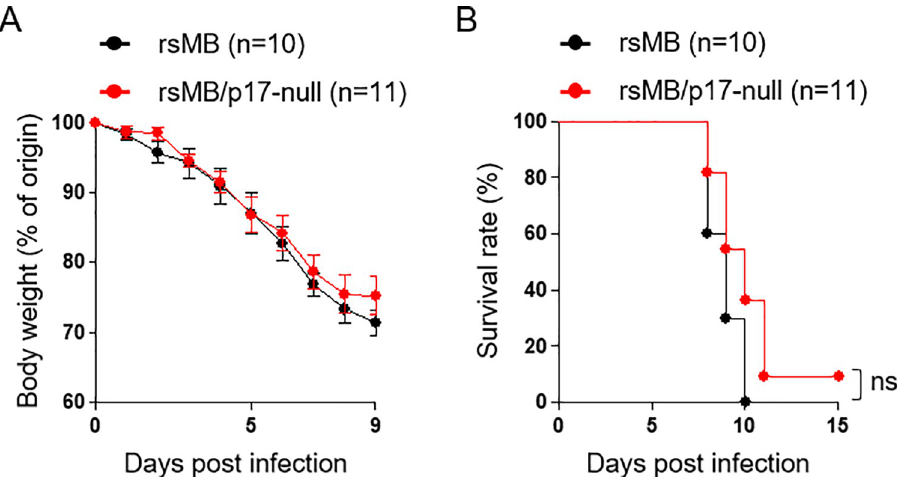
Fig 2. NBV p17 does not affect viral pathogenesis in vivo . C3H mice were intranasally infected with rsMB (n = 10) or rsMB/p17-null (n = 11). Virus suspensions (20 μ L) including 3 × 10 5 PFU virions were inoculated. No significant difference in body weight (A) or survival (B) was detected between groups. Error bars indicate standard deviations. ns, not significant (log rank test, p > 0.05).